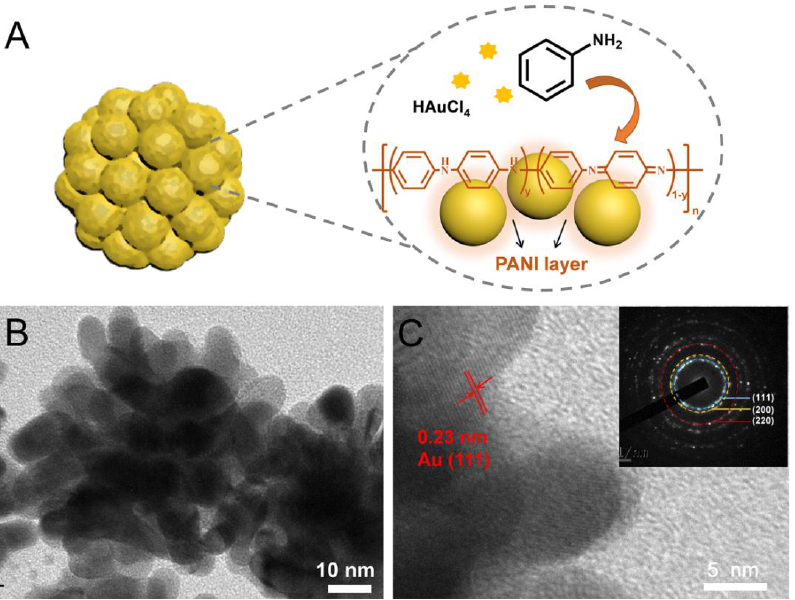
Figure 1. ( A ) Schematic illustration of HAuCl 4 reduction by aniline to fabricate raspberry-like pAuNCs. ( B ) TEM and ( C ) HR-TEM images of the pAuNCs (inset: SAED image of pAuNCs).